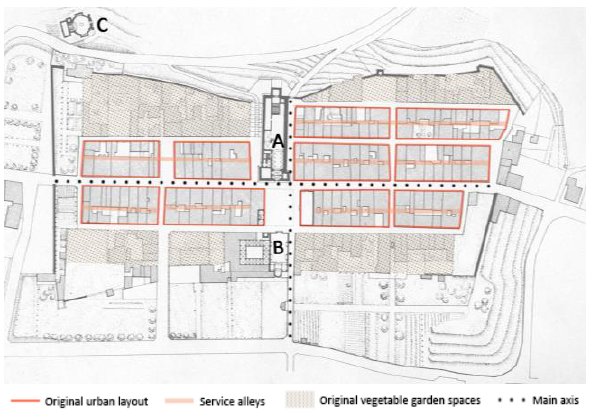
Figure 1. Original urban layout of